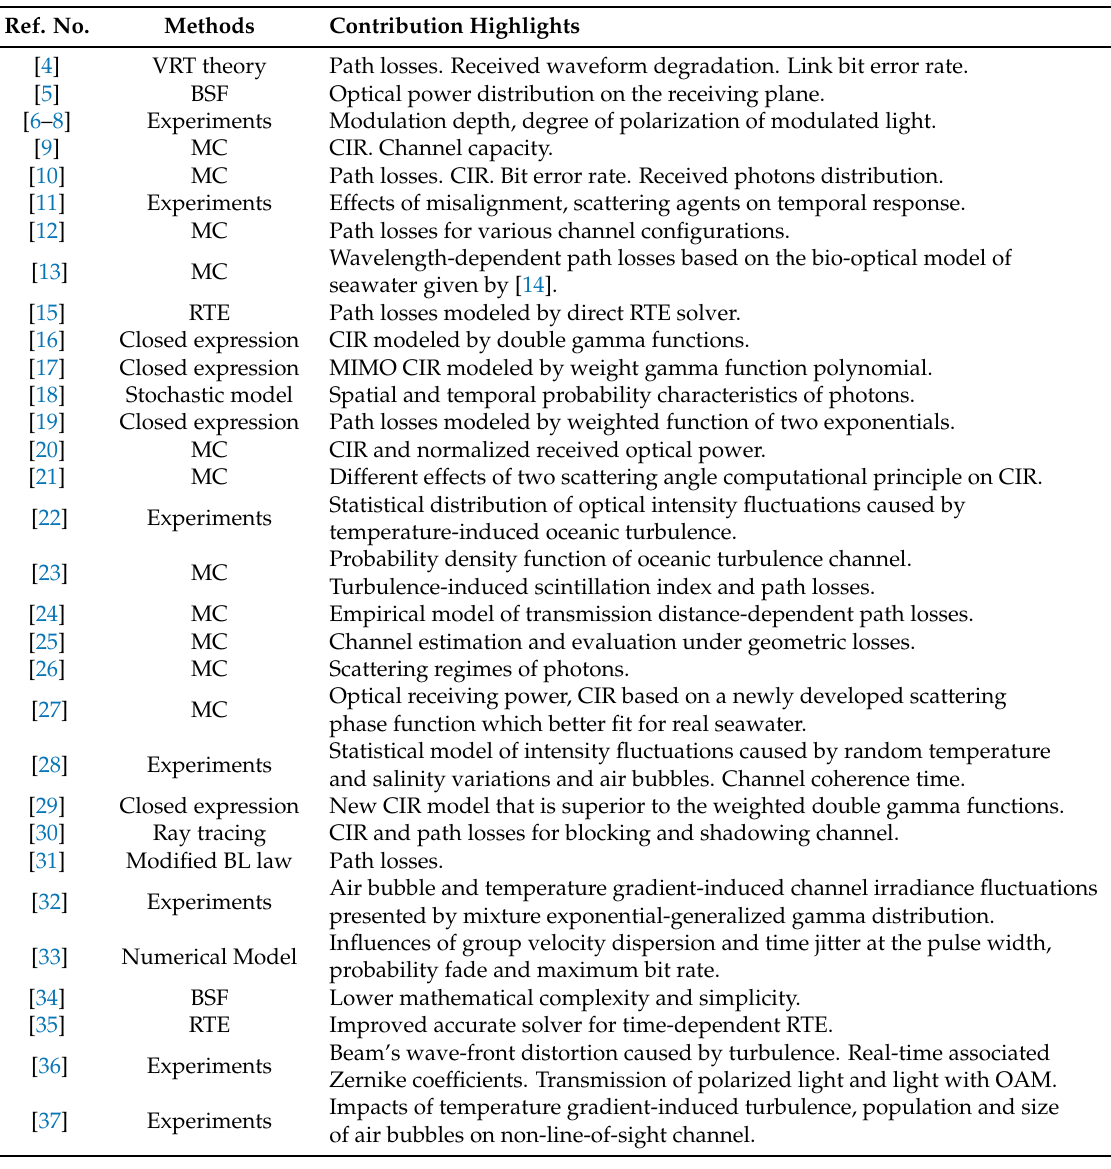
Table 1. Survey of recent underwater optical channel